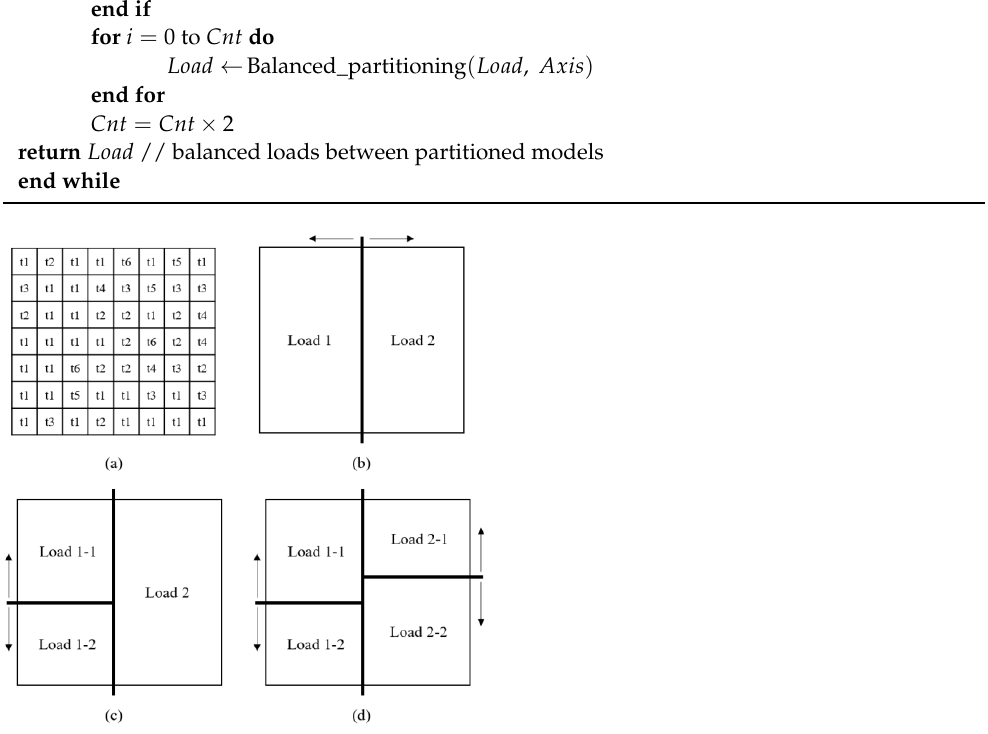
Figure 7. The balanced partitioning process, based on the k-d tree algorithm: ( a ) predicted computing load map of disaster semantic data; ( b ) dividing the load map based on the x-axis into balanced Loads 1 and 2; ( c ) dividing the Load 1 into the two balanced loads based on the y-axis, Loads 1-1 and 1-2; ( d ) partitioning Load 2 into Load 2-1 and Load 2-2, following the y-axis.